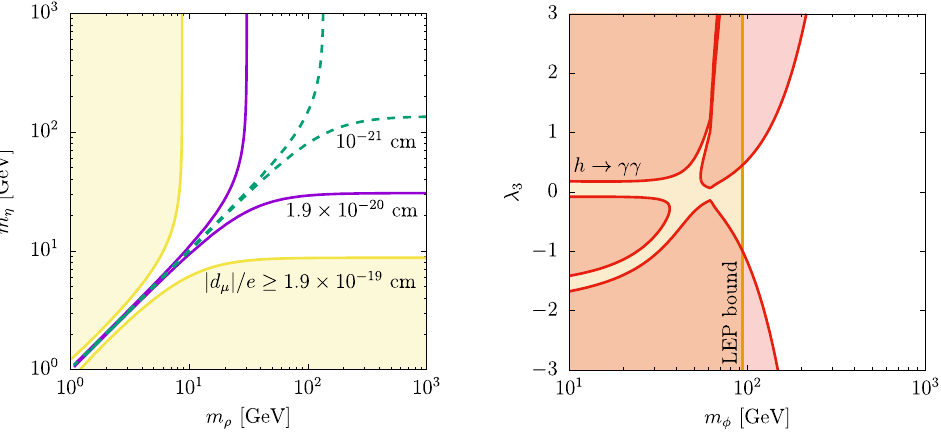
Figure 8 . Left: contours of muon EDM d (cid:22) =e where Im ( y (cid:22)(cid:28) y (cid:28)(cid:22) ) = 1. The yellow region is j j excluded by the Muon g 2 Collaboration, and the solid purple and dashed green lines are the (cid:0) future prospect of EDM experimental reach. Right: parameter space excluded by h strength (red) and the LEP bound (orange) in ( m (cid:30) , (cid:21) 3 )